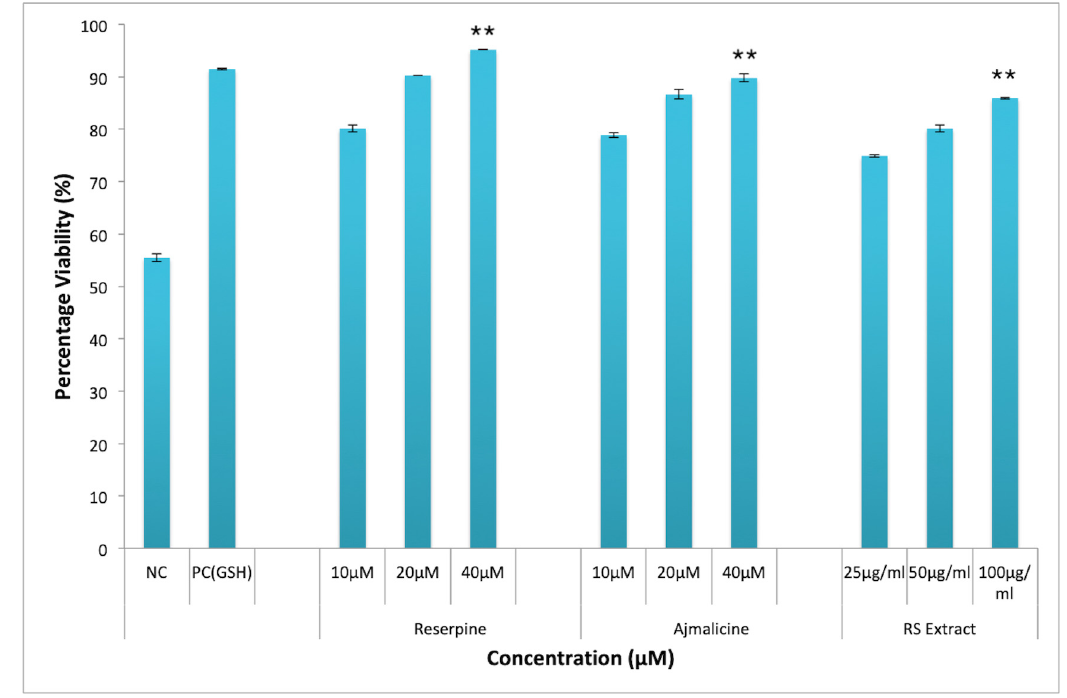
Figure 10. Neuroprotective effect against H 2 O 2 induced cytotoxicity in PC12 cells; RES—Reserpine (40, 20, 10 μ M); AJM—Ajmalicine (40, 20, 10 μ M); RS— R.serpentina extract (100, 50, 25 μ g/mL); PC: positive control (Glutathione, 40 μ M); NC—negative control (H 2 O 2 alone, 200 μ M); values represents mean ± SEM, n = 3; and difference in mean is statistically significant (**) p < 0.05 as compared to control group.